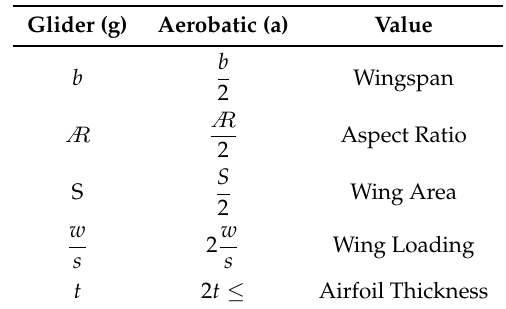
Table 1. Aircraft main